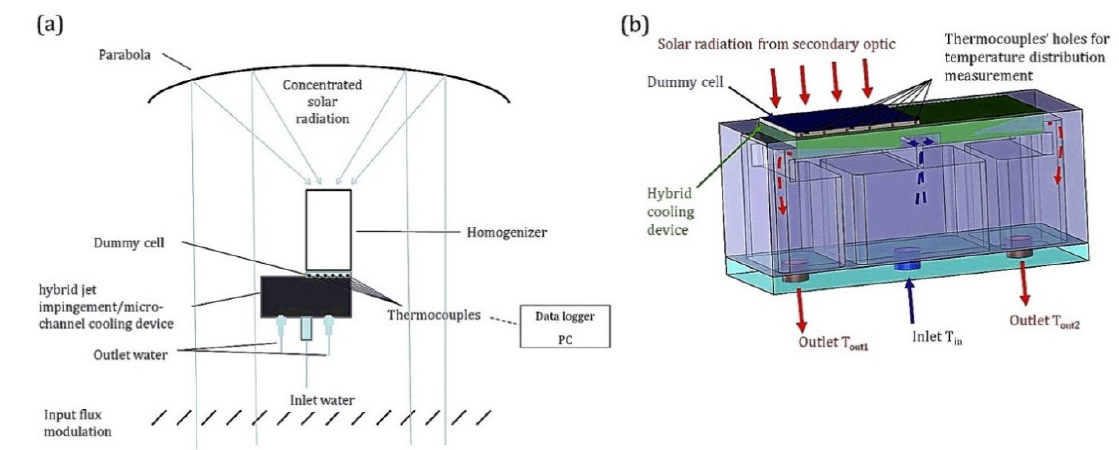
Figure 24. Schematic of the concentration system ( a ) and cooling device ( b ) [104].